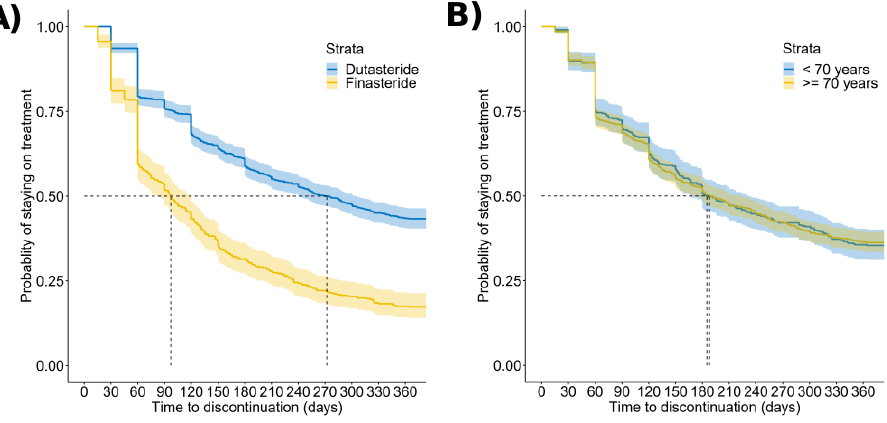
Figure 2. Persistence to treatment with 5ARIs. ( A ) Kaplan-Meier curves of the time to discontinuation for specific drugs (dutasteride, N = 1064; finasteride, N = 416); ( B ) Kaplan-Meier curves of the time to discontinuation for younger (<70 years of age, N = 420) and older (≥70 years of age, N = 987) men. Table 2. Persistence to ABs and to 5ARIs at 365 days.